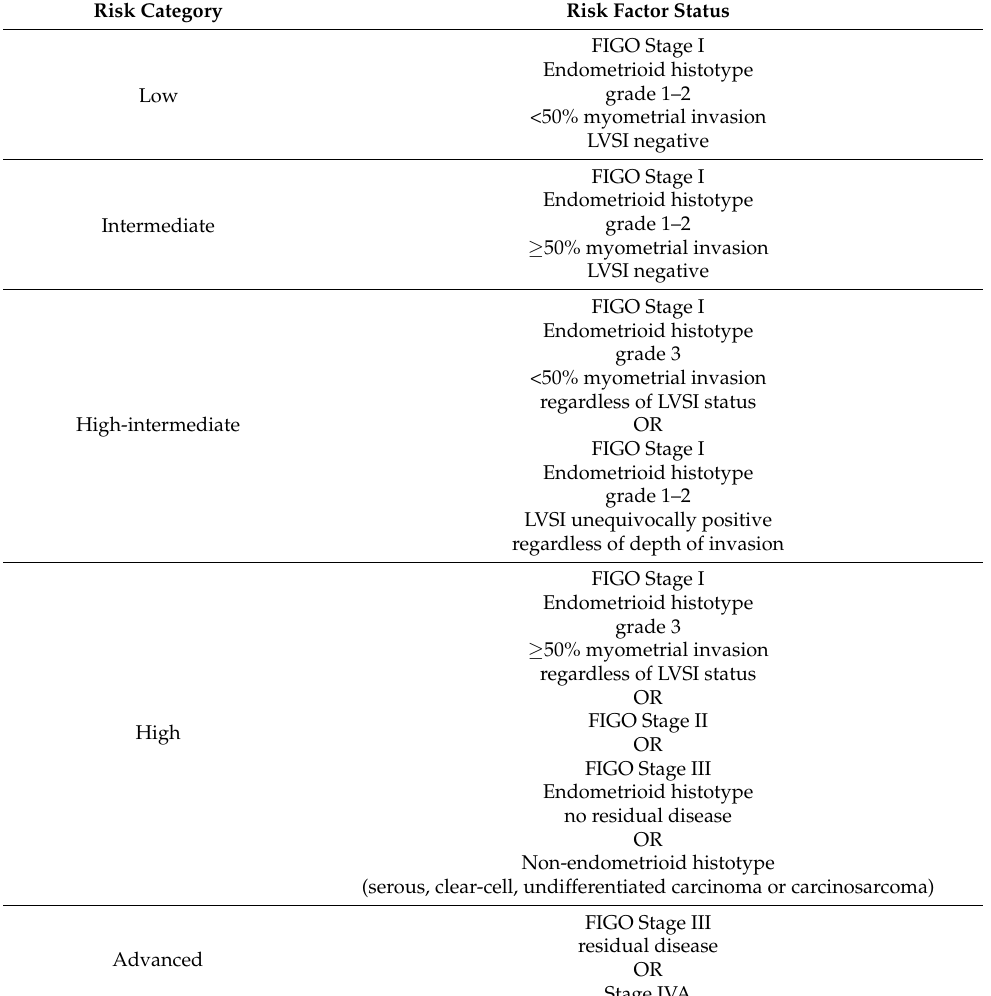
Table 2. Endometrial cancer ESMO/ESGO/ESTRO classification